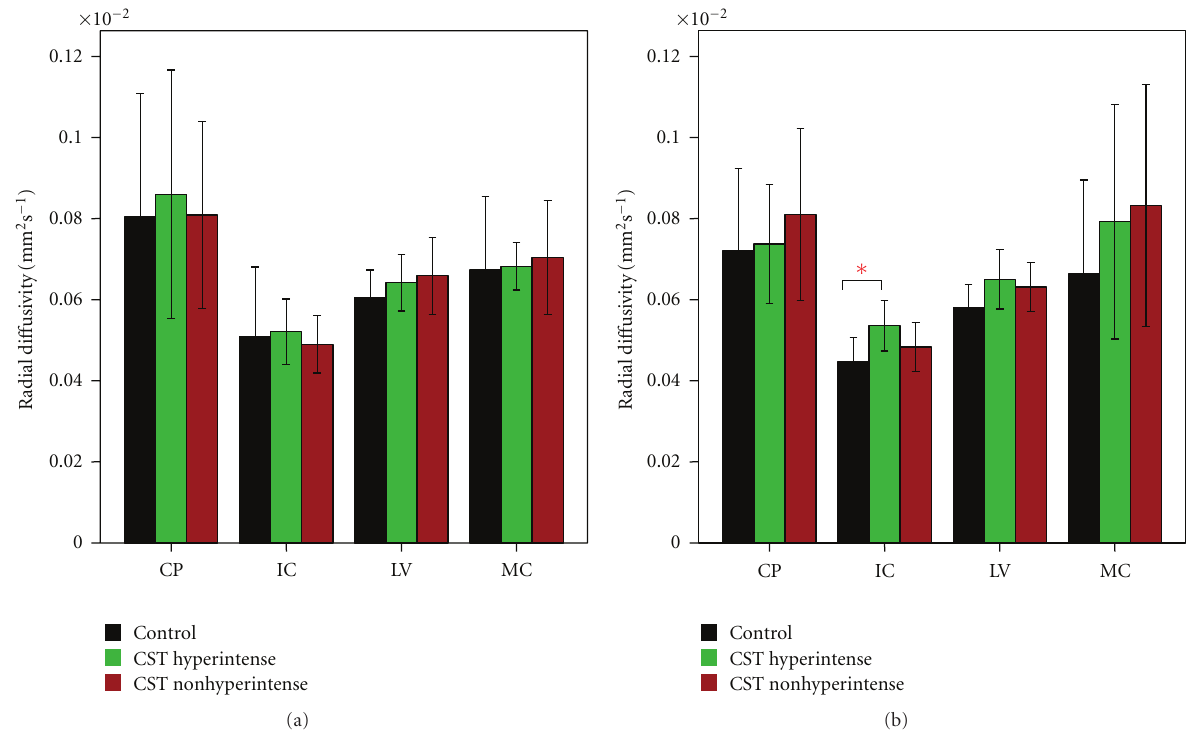
Figure 5: Radial di ff usivity (RD) at four CST levels on left (a) and right (b), revealing significantly higher values at the IC level on the right in only CST hyperintense patients compared to controls. ∗ P < 0 . 05. Key: CP, cerebral peduncle; IC, posterior limb of internal capsule, LV, centrum semiovale at top of lateral ventricle, MC, subcortical to motor cortex.